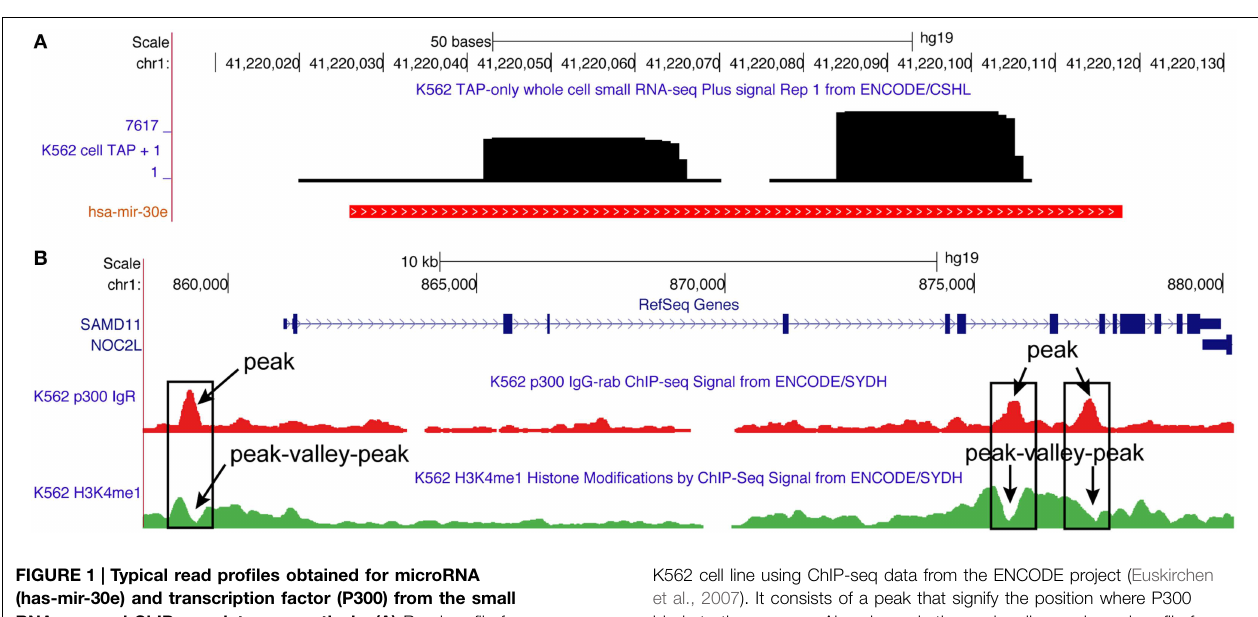
K562 cell line using ChIP-seq data from the ENCODE project ( Euskirchen et al., 2007). It consists of a peak that signify the position where P300 binds to the genome. Also shown is the peak-valley-peak read profile for histone modification (H3K4me1) observed at P300 peaks (O’Geen et al., 2011). Both P300 (peak) and H3K4me1 (peak-valley-peak) read profiles are enriched at enhancer regions ( Merika et al., 1998; Heintzman et al., 2007), and are thus useful for their annotation in the